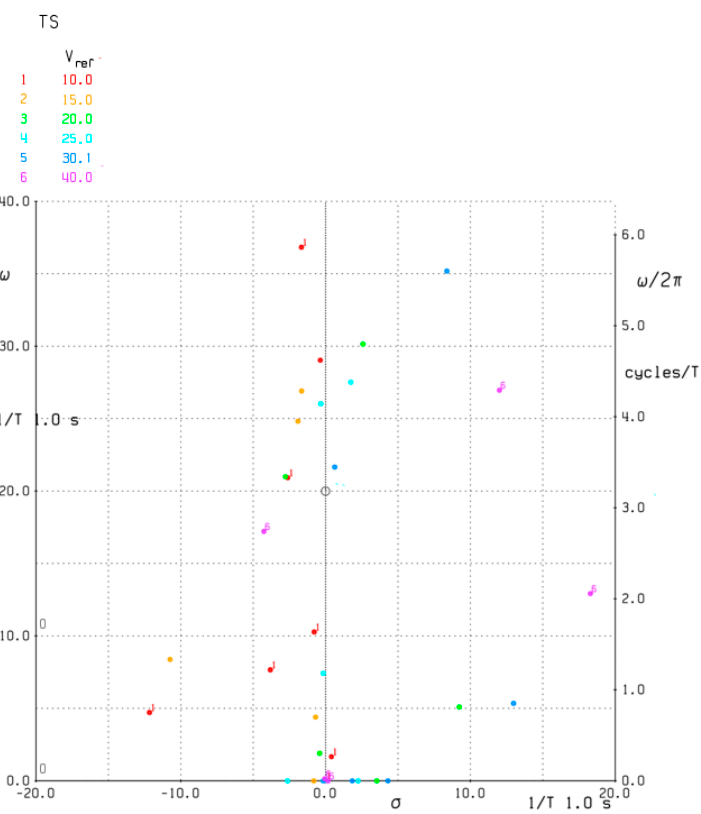
Figure 22. Eigenvalues of TWIN STRATOS UAV.